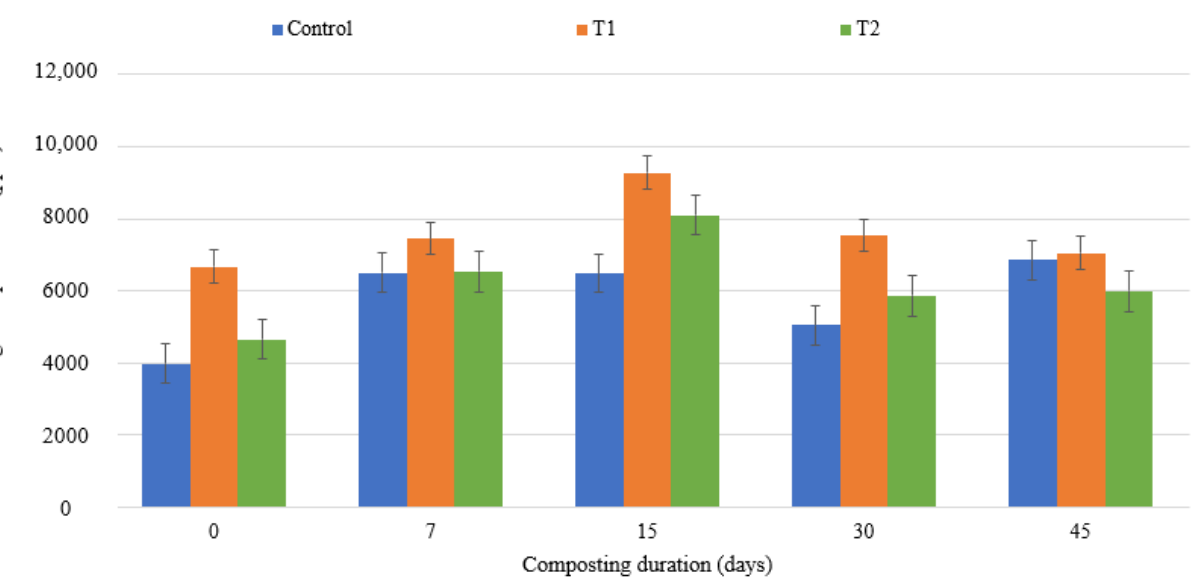
Figure 10. Changes in the levels of exchangeable potassium in control, T1, and T2 samples at 0, 7, 15, 30, and 45 days.